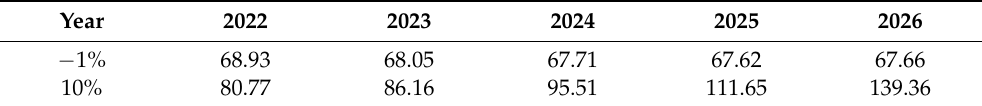
Table 21. Prediction result of water requirement with different growth rates of AVSI in Shanxi Province.